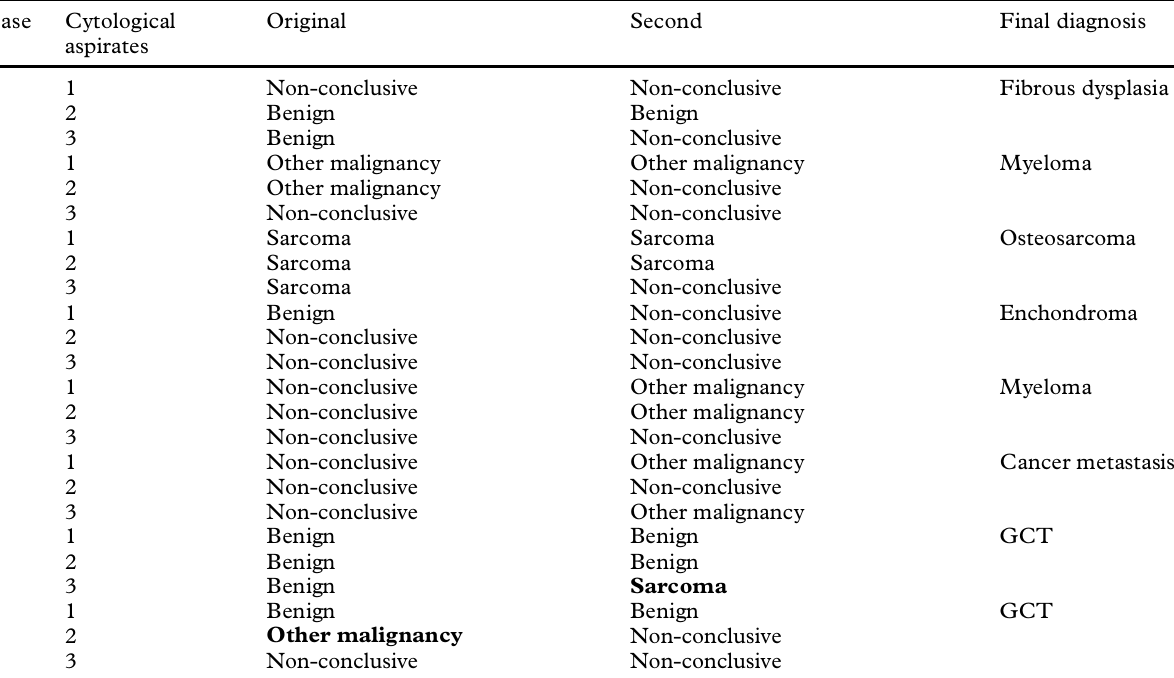
Table 4. The eight non-compliant cases